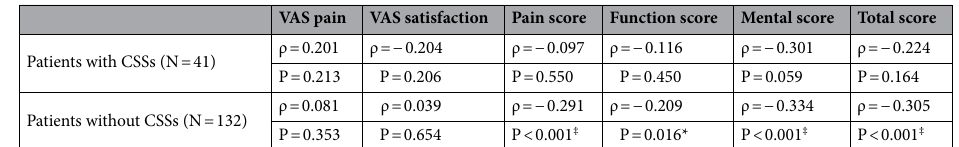
Table 3. Correlations between the pre-operative central sensitization inventory score and post-operative clinical outcomes in patients with and without central sensitivity syndromes. VAS satisfaction, pain, function, mental, and total scores were examined using the Japanese Orthopaedic Association Hip-Disease Evaluation Questionnaire. Correlation coefficient is represented by ρ. P < 0.05 indicates statistical significance. *P < 0.05 and ‡ P < 0.001. CSI central sensitization inventory, VAS visual analog scale, CSS central sensitivity syndrome.